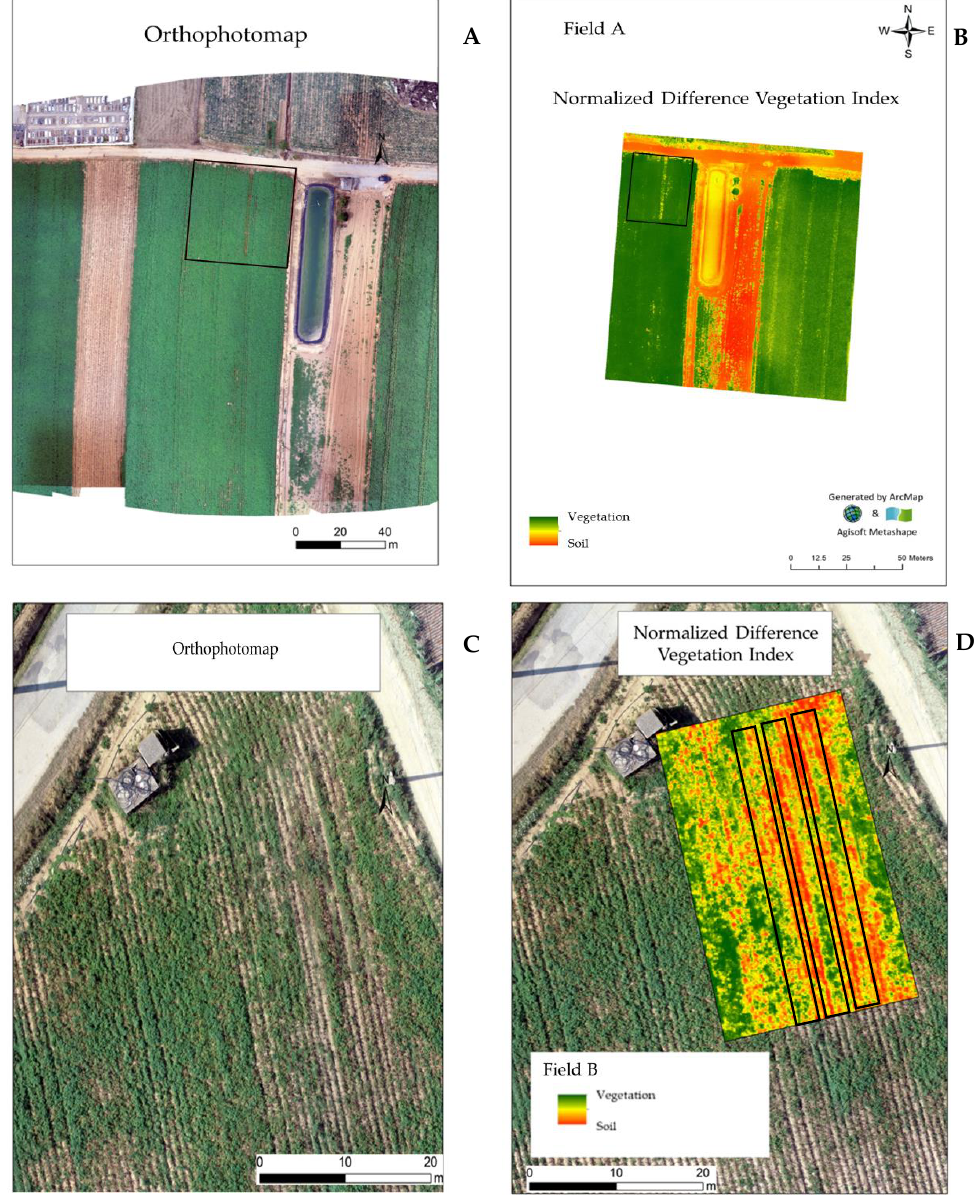
Figure 2. Orthophotomaps ( A , C ) and NDVI models ( B , D ) of S. tuberosum L. fields (Fields A—Picasso variety and B—Agria variety), after four and six foliar applications, respectively. In Field A, the information was collected four days after the fourth foliar application, and in Field B, six days after the sixth foliar application. The indication (in black) of field limits in the maps. Regard- ing the NDVI models, varying from −1 to 1, the color red corresponds to −1 (soil), and the color green corresponds to 1 (higher plant vigor).